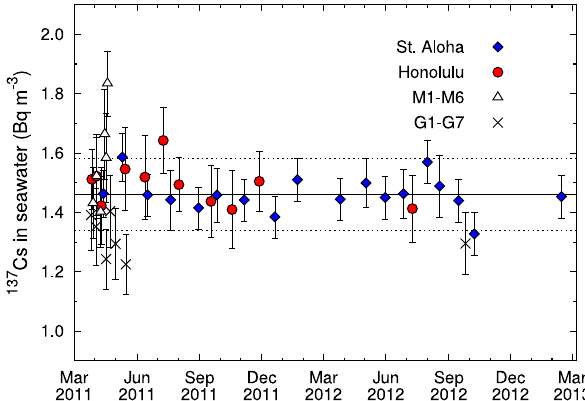
Fig. 2. 137 Cs activities in surface seawater around the Hawaiian Is- lands (M1–M6), Guam (G1–G7), and time series for Station Aloha and Honolulu. The solid line is an average for Station Aloha, and dashed lines are ± 2 standard deviations of the